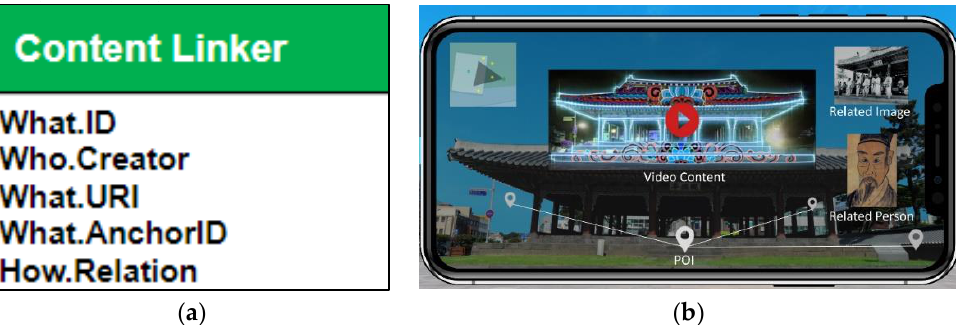
Figure 4. The content linker metadata: ( a ) the content linker metadata and ( b ) an example of implementation using the content linker metadata.